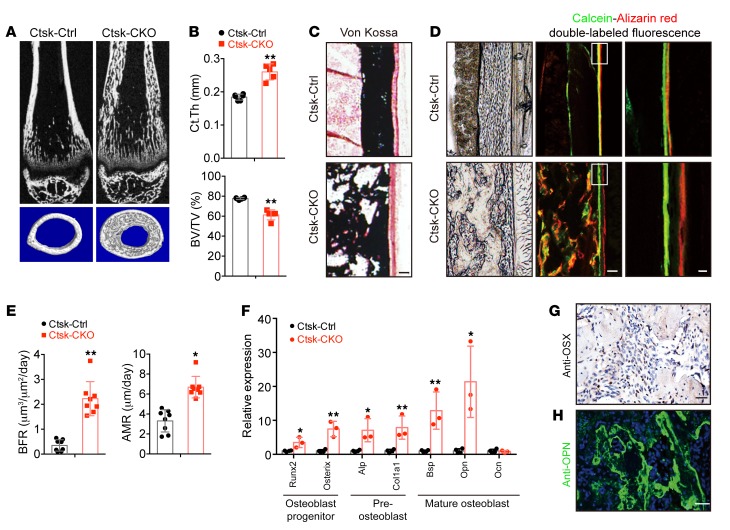
Lkb1 deletion in Ctsk-Cre–expressing cells leads to increased bone formation.(A) μCT analysis of femurs from 5-week-old female Ctsk-Ctrl and Ctsk-CKO mice. (B) Ct.Th and BV/TV of the cortical bones of femurs from 5-week-old female Ctsk-Ctrl and Ctsk-CKO mice (n = 5 for each group). (C) von Kossa staining of the tibiae from 5-week-old female Ctsk-Ctrl and Ctsk-CKO mice. Scale bar: 100 μm. (D and E) Calcein–alizarin red double-labeled fluorescence of the tibiae from 5-week-old female Ctsk-Ctrl and Ctsk-CKO mice showing MAR and BFR of the periosteum (n = 3 for each group). Scale bars: 100 μm (left); 10 μm (right). (F) Gene expression of markers for osteoblast progenitor (Runx2 and Osx), preosteoblast (Alp and Col1a1), and mature osteoblast (Opn, Bsp, and Ocn) of the cortical bones of 20-week-old female Ctsk-CKO mice (n = 3) compared with Ctsk-Ctrl mice (n = 4) tibiae. (G and H) Immunostaining of OSX (G) and OPN (H) in the tumor osteoid of Ctsk-CKO tibiae. Scale bars: 50 μm. Data are represented as mean ± SEM. *P < 0.05; **P < 0.01, unpaired Student’s t test.